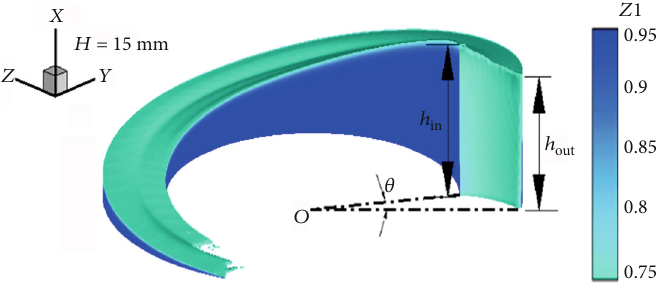
Figure 6: 3D distribution of detonation